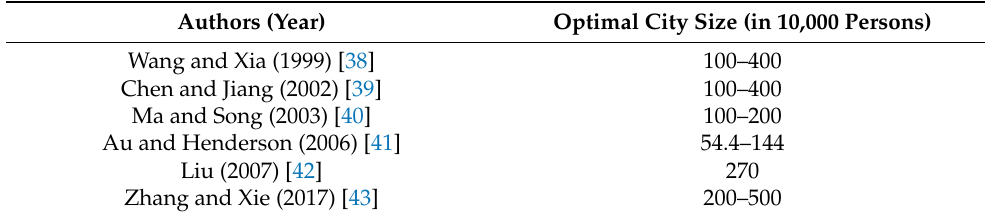
Table 9. Optimal city size in the early